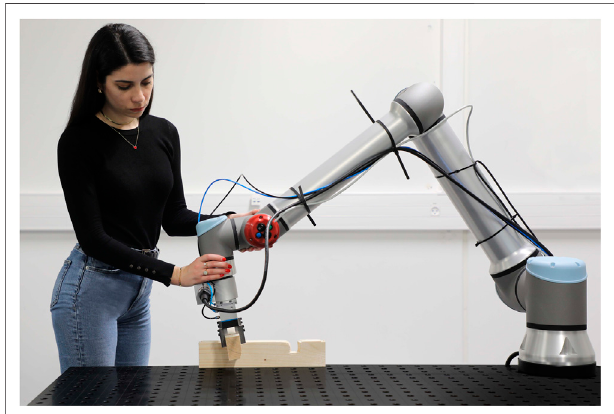
FIGURE 6 | Demonstration of the robot based assembly policy for timber